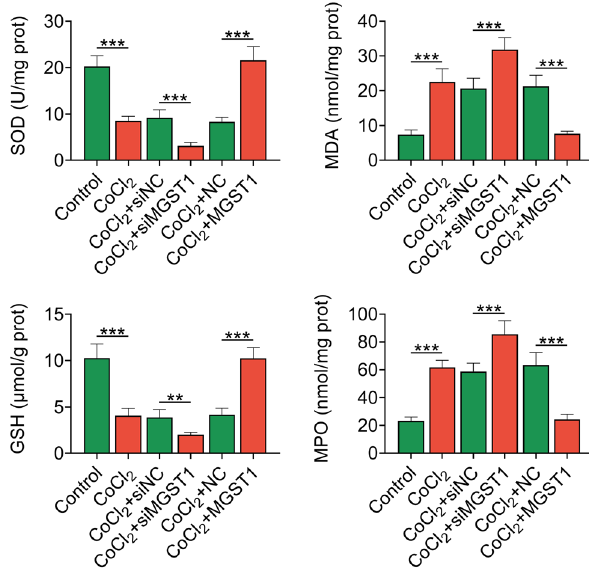
Figure 3: MGST1 upregulation alleviated the hypoxia - induced oxidative stress in trophoblast cell. Groups were divided into the control, CoCl 2 , CoCl 2 + siNC,CoCl 2 + siMGST1, CoCl 2 + NC, and CoCl 2 + MGST1 group. ELISA unveiled the concentrations of oxidative stress - related proteins ( SOD, MDA, GSH, and MPO ) . ** P < 0.01, *** P <